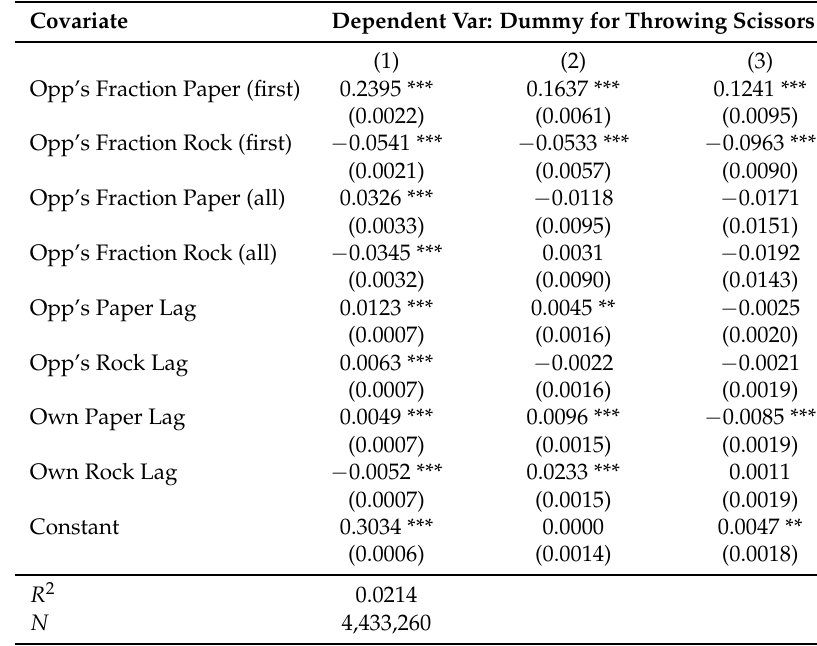
Table A5. Probability of Playing Scissors.